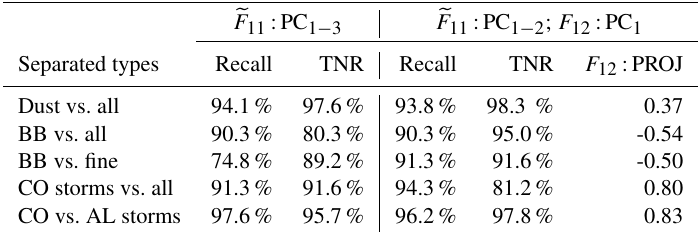
Table 4. Recall and TNR values resulting from the separating plane classification prediction technique for two different combinations of principal component scores. The value of F 12 :PROJ contains a parameter quantifying the role of the first principal component of − F 12 /F 11 in identifying the corresponding aerosol